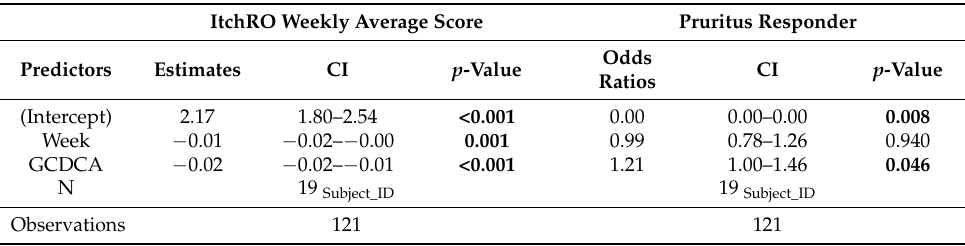
Table 3. Summary of the linear and general linear mixed models (LMM and GLMM) of ItchRO score ~ GCDCA (%).